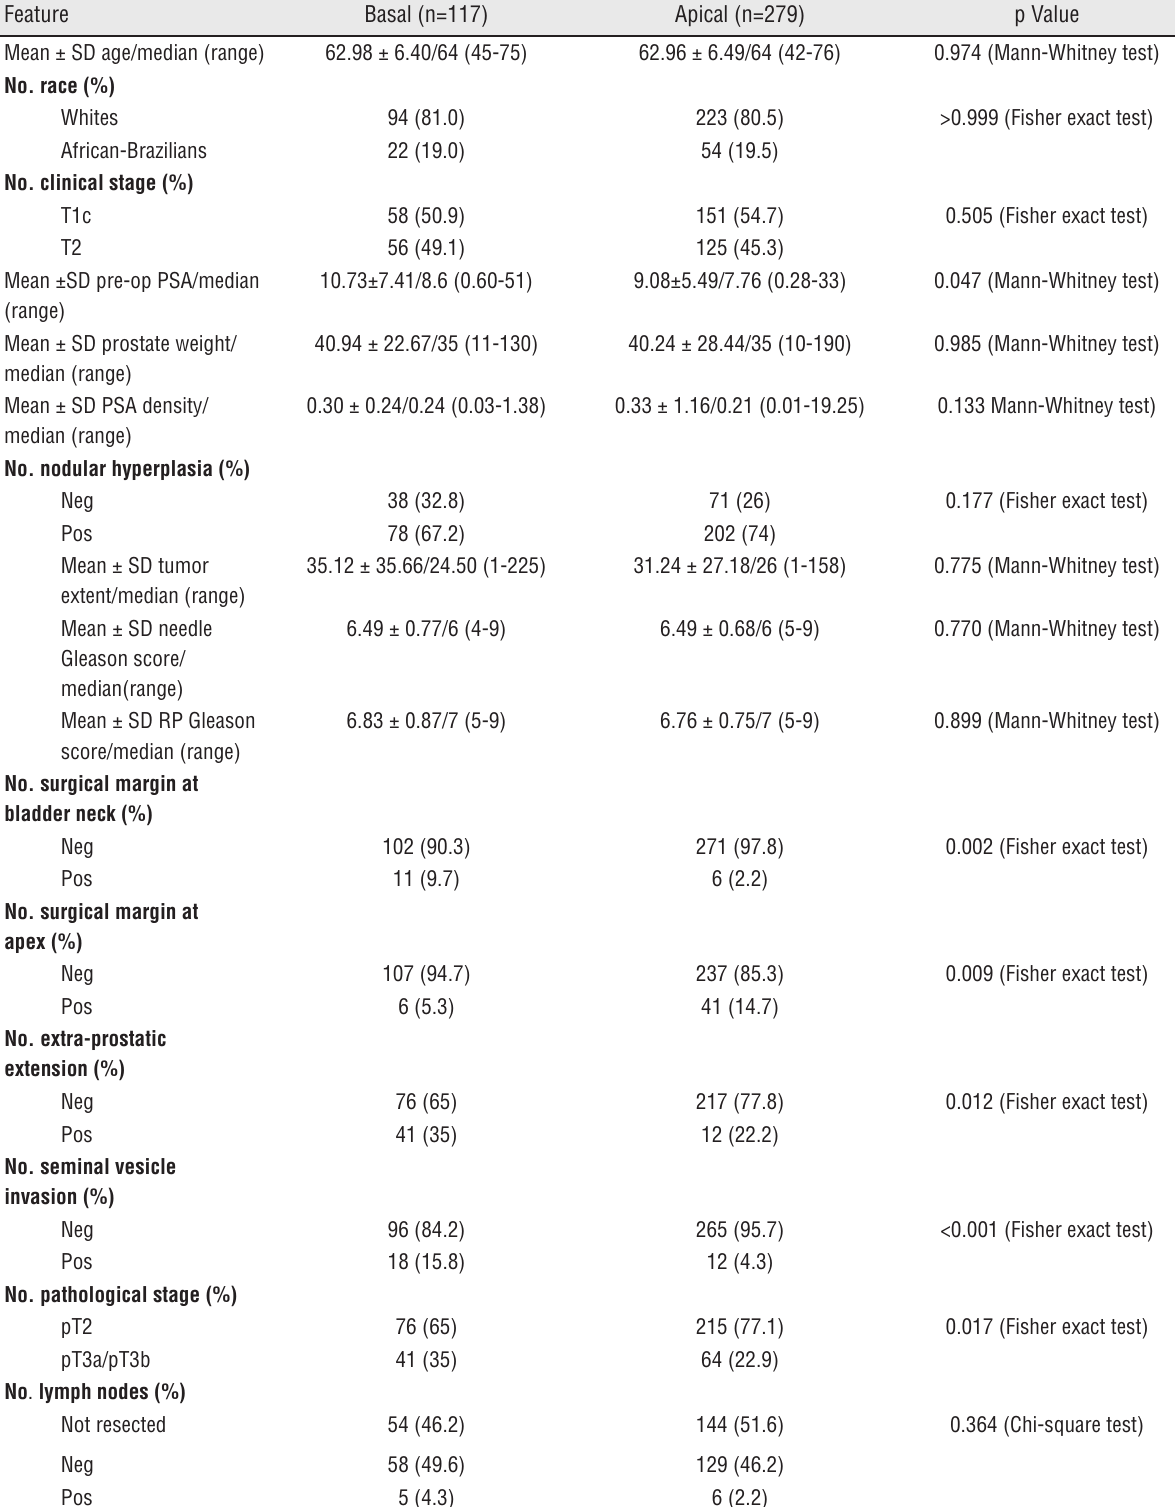
Table 2 - clinicopathological features of 396 patients by index tumor predominant location.